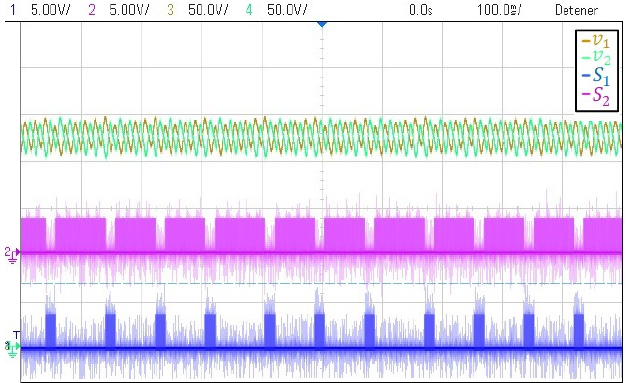
Figure 22. Waveforms of v 1 , v 2 , S 1 and S 2 for I s = 153mA.